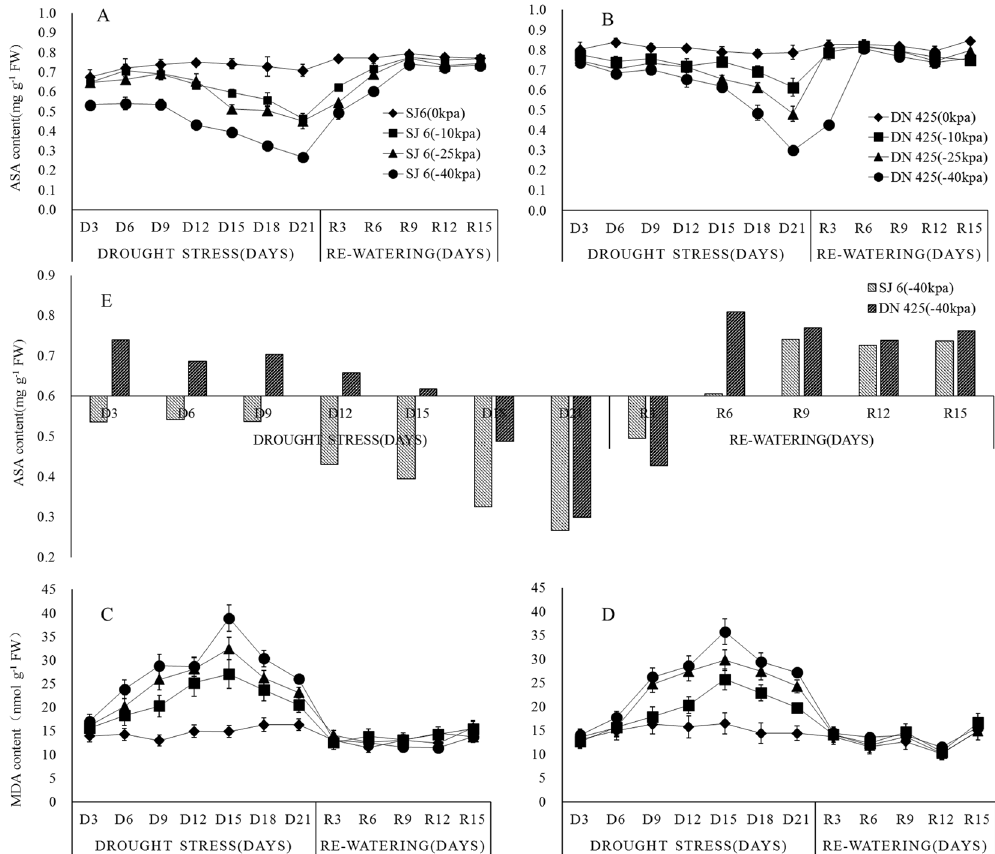
Figure 3. Effects of drought stress and re-watering on ASA ( A , B ) and MDA ( C , D ) content in leaves at tillering stage of two rice cultivars in all treatments. The ASA content of SJ6 and DN425 in − 40 kPa treatment ( E ). SJ6, Songjing 6 (drought-sensitive); DN425, Dongnong 425 (drought-tolerant). The values represent the means ± SD (n = 3). The experiment was conducted at Northeast Agricultural University farm,